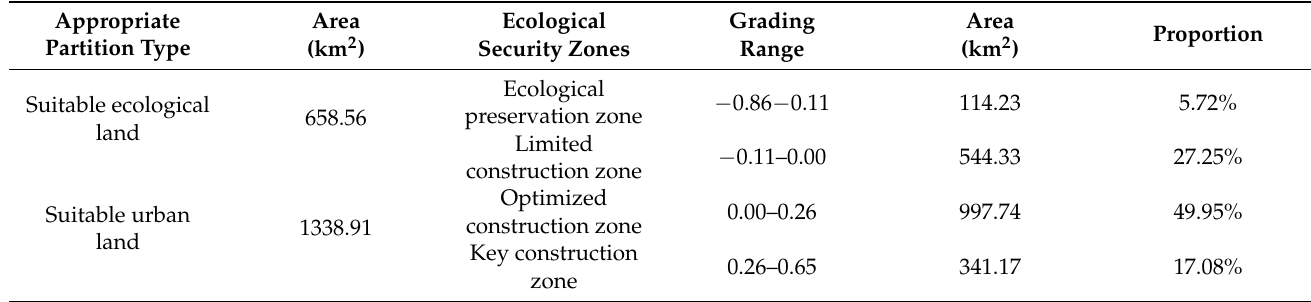
Table 6. Ecological security zoning.